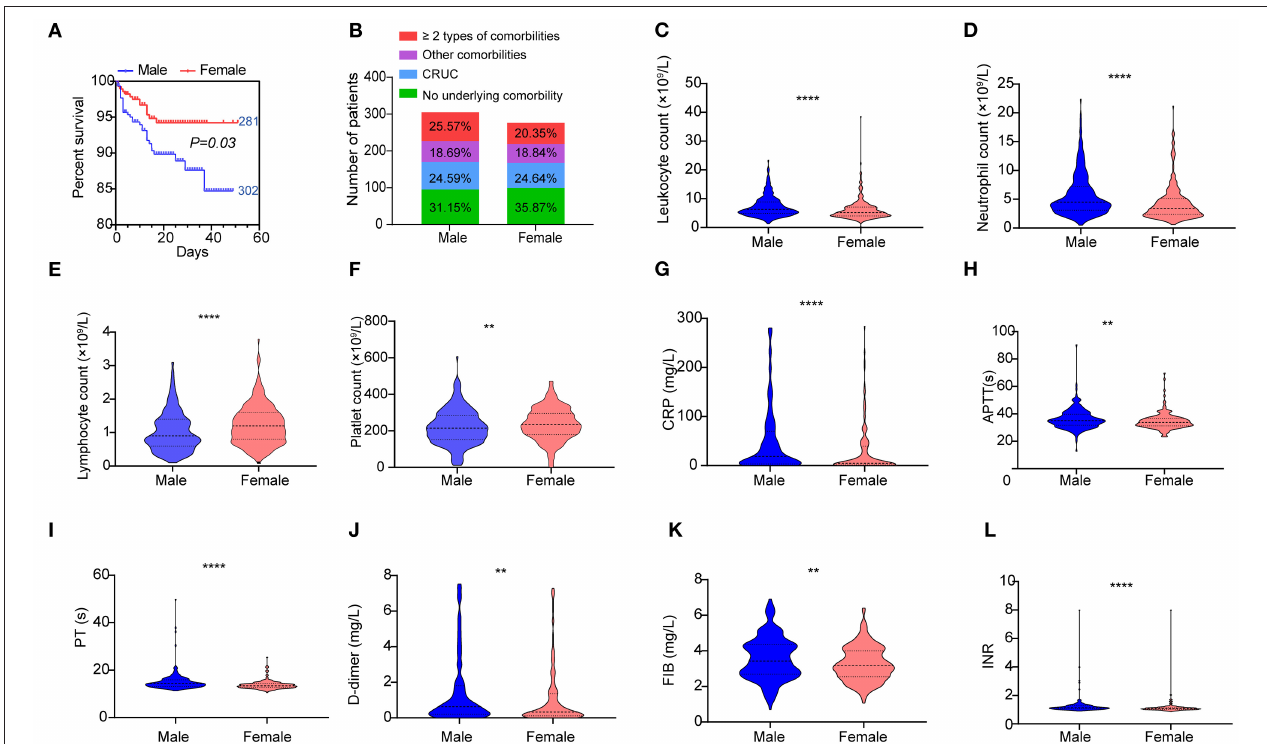
FIGURE 7 | Hematologic variations between the male and female. (A) Kaplan–Meier survival curves for genders are shown. (B) Composition of different underlying comorbidities in the male and female. Different levels of hematologic indices (C) leukocytes, (D) neutrophils, (E) lymphocytes, (F) platelets, (G) CRP level, (H) APTT, (I) PT, (J) D-dimer level, (K) FIB, and (L) INR between the male and female. Data are shown as a violin plot with median and 25 and 75% percentile lines. ** P < 0.01, **** P < 0.0001. The numbers next to the survival curves indicate quantities of patients in such a